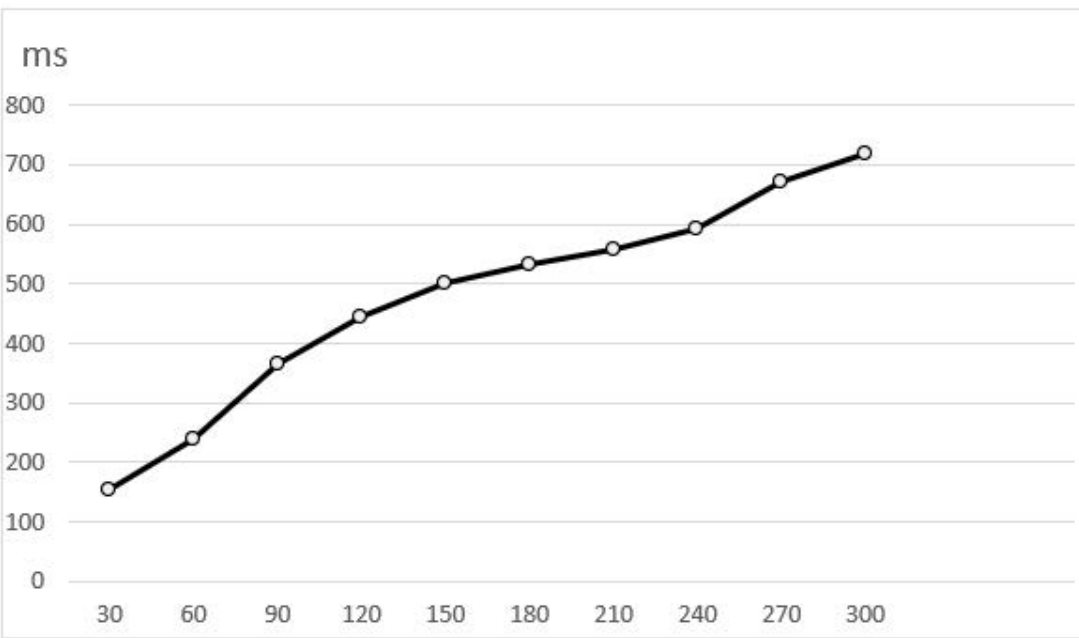
Figure 11. Average user access